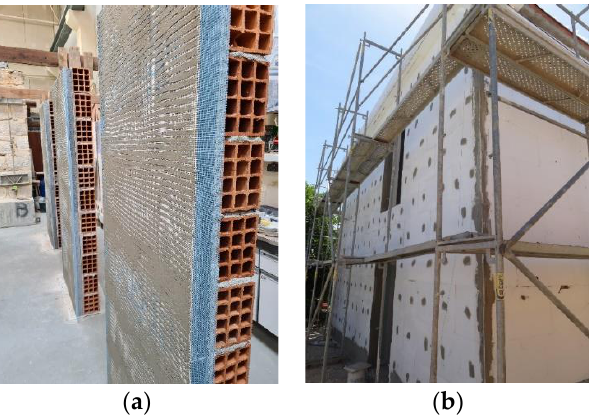
Figure 2. Examples of the application of external thermal insulation composite system: ( a ) walls in-laboratory; ( b ) two-story infilled reinforced concrete building.